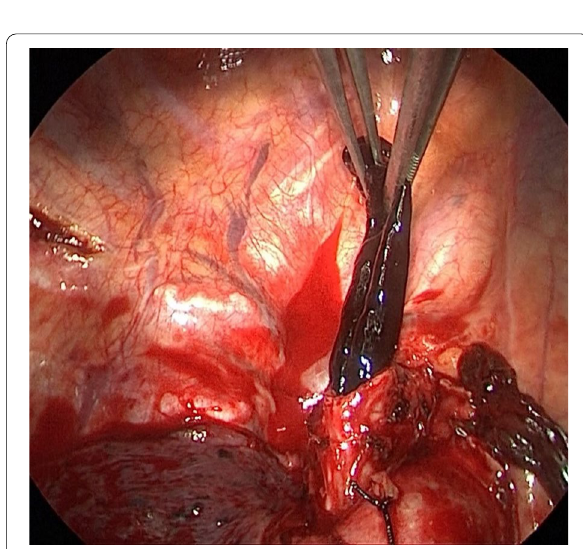
Fig. 3 The hematoma in the airway was carefully pulled out with forceps from the end of the bronchus that had been separated